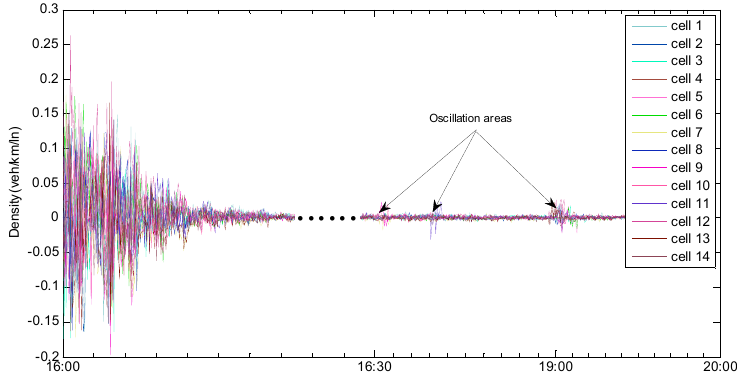
Figure 8. Error curve of state jump observer.